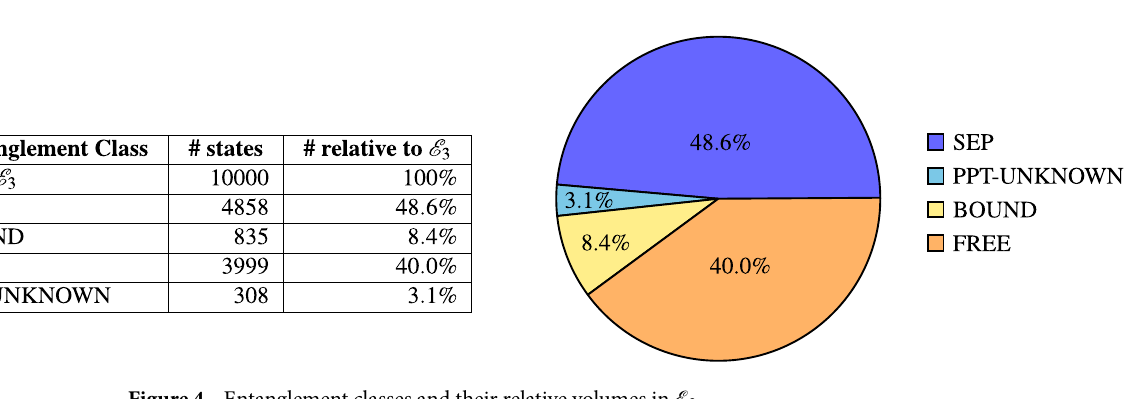
Figure 4. Entanglement classes and their relative volumes in E 3